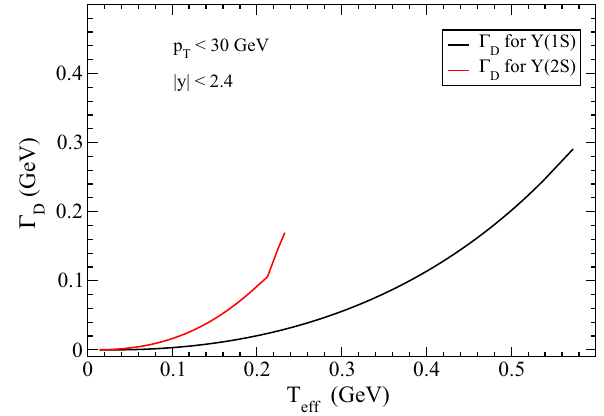
Fig. 5 Variation of ϒ( 1 S ) and ϒ( 2 S ) total decay width along with its components i.e., gluonic dissociation and collisional damping versus effective